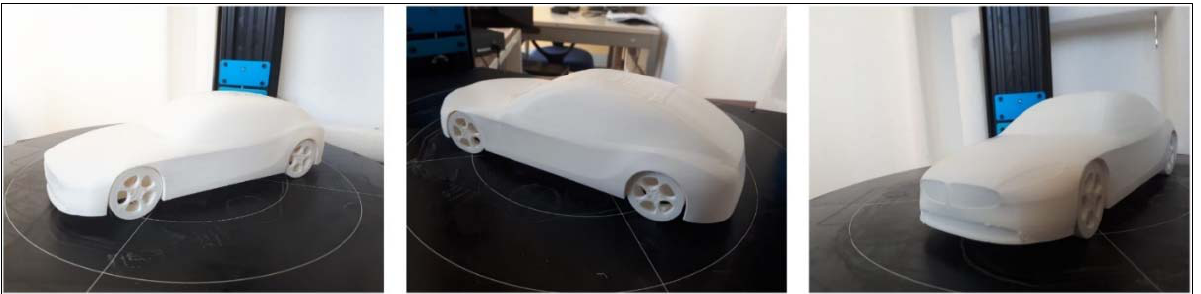
Figure 22. Additive manufacturing moquette of Blitz Vision Retro.